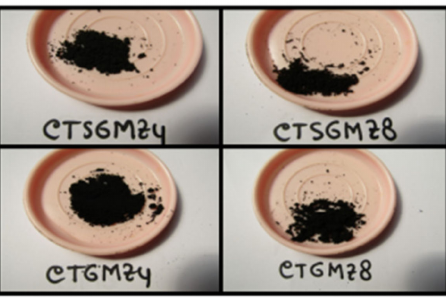
Figure 9. The final composites (ZnCr 2 O 4 /CNS) which resulted from pyrolysis at 400 W (code 4) and 800 W (code 8) with activator of ZnCl 2 (Z) and calcination at 600 W using